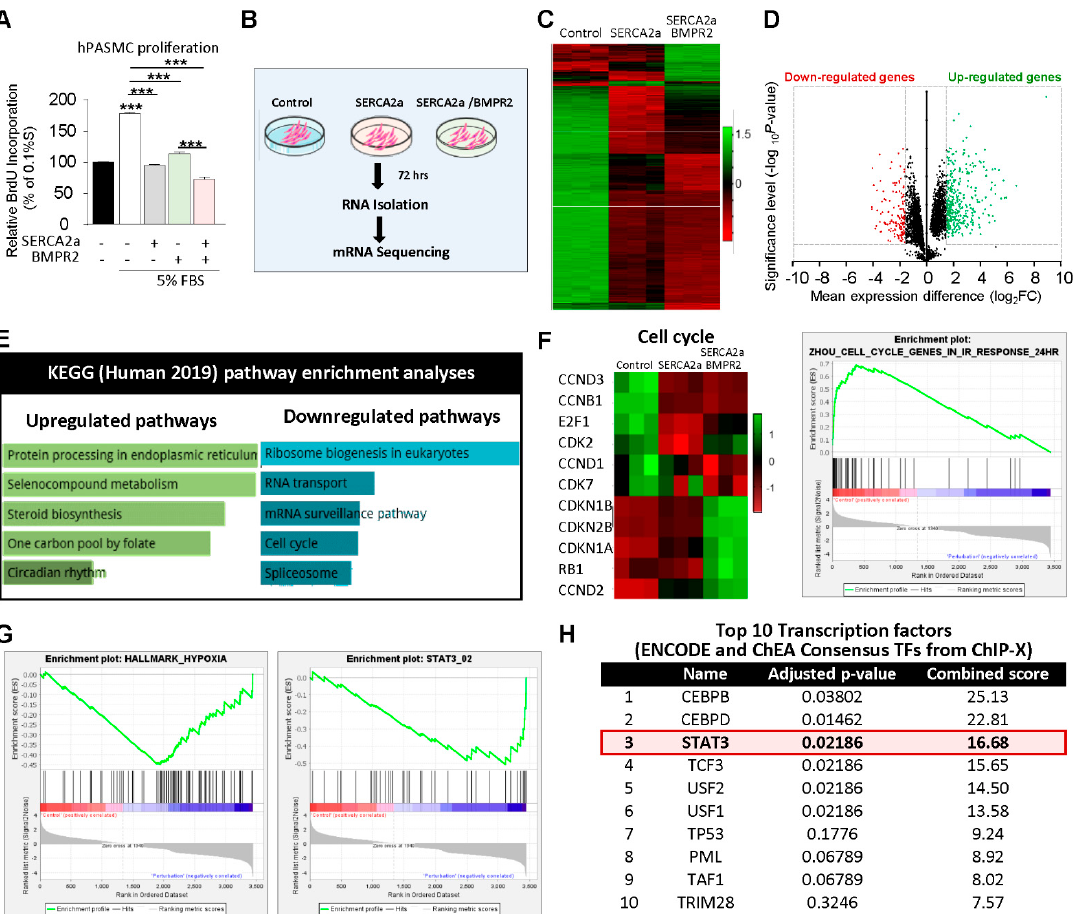
Figure 2. RNA-Seq analysis defines the transcriptome profile of hPASMCs overexpressing SERCA2a and BMPR2 and identifies STAT3 as a potential therapeutic target. ( A ). Proliferation was measured through BrdU assay in hPASMCs overexpressing SERCA2a alone and/or in combination with BMPR2 cultured in 0.1% or 5% FBS for 72 h (n = 5). ( B ). A schematic representation of the RNA sequencing and experimental groups. RNA extraction was performed in hPASMCs overexpressing either an adenovirus encoding β -Galactosidase (control), SERCA2a alone, or in combination with BMPR2 (n = 3). ( C ). Heatmap displaying differential gene expression (DEG) for each sample in the RNA-seq dataset. Each row of the heatmap represents a gene, and each column represents a sample. Down- and up-regulated genes are noted in red and green, respectively. ( D ). Volcano plots showing log2-fold changes and the statistical significance of each gene calculated after DEG analysis. Red points indicate significantly down-regulated genes; green points indicate up-regulated genes. ( E ). RNA-Seq datasets were analyzed using the Kyoto Encyclopedia of Genes and Genomes (KEGG) 2019 database to identify the top 5 up-and down-regulated pathways after SERCA2a and BMPR2 co-overexpression. ( F ). Left panel: heatmap illustrating the expression of genes implicated in the cell cycle. Right panel: Gene Set Enrichment Analysis (GSEA) reveals that cell cycle genes show statistically significant differences in regulation. ( G ). GSEA analysis shows that SERCA2a and BMPR2 overexpression in hPASMCs significantly regulate hypoxia and STAT3-regulated genes. ( H ). Analysis of the RNA-Seq datasets using the ENCODE and ChEA Consensus transcription factors (TFs) from ChIP-X database identified STAT3 among the top 10 regulated TFs. P -value and combined score are shown for each TFs. Data are presented as mean ± SEM; *** p <